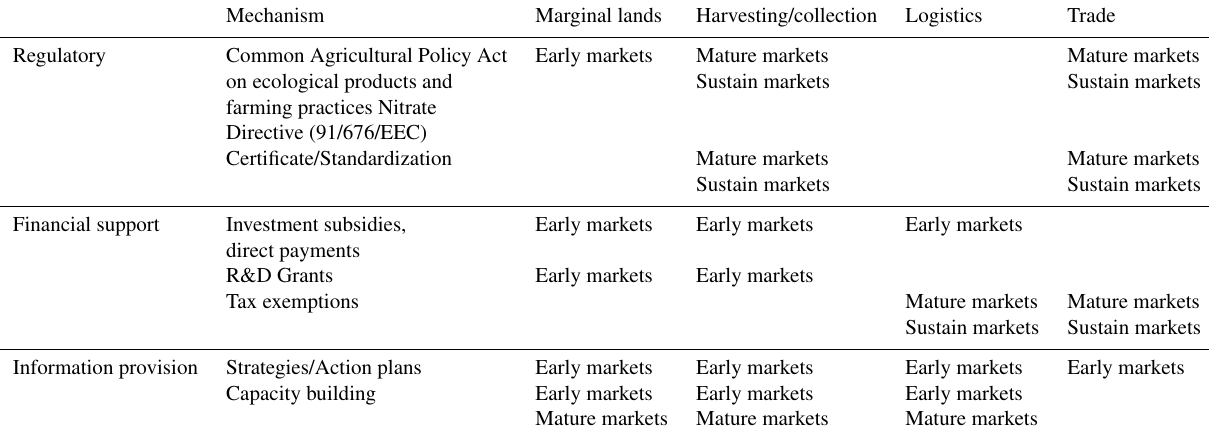
Table 9. Policy mechanisms relevant to biomass from marginal land per value chain step, type of policy and market stage development (adapted from Panoutsou et al.,